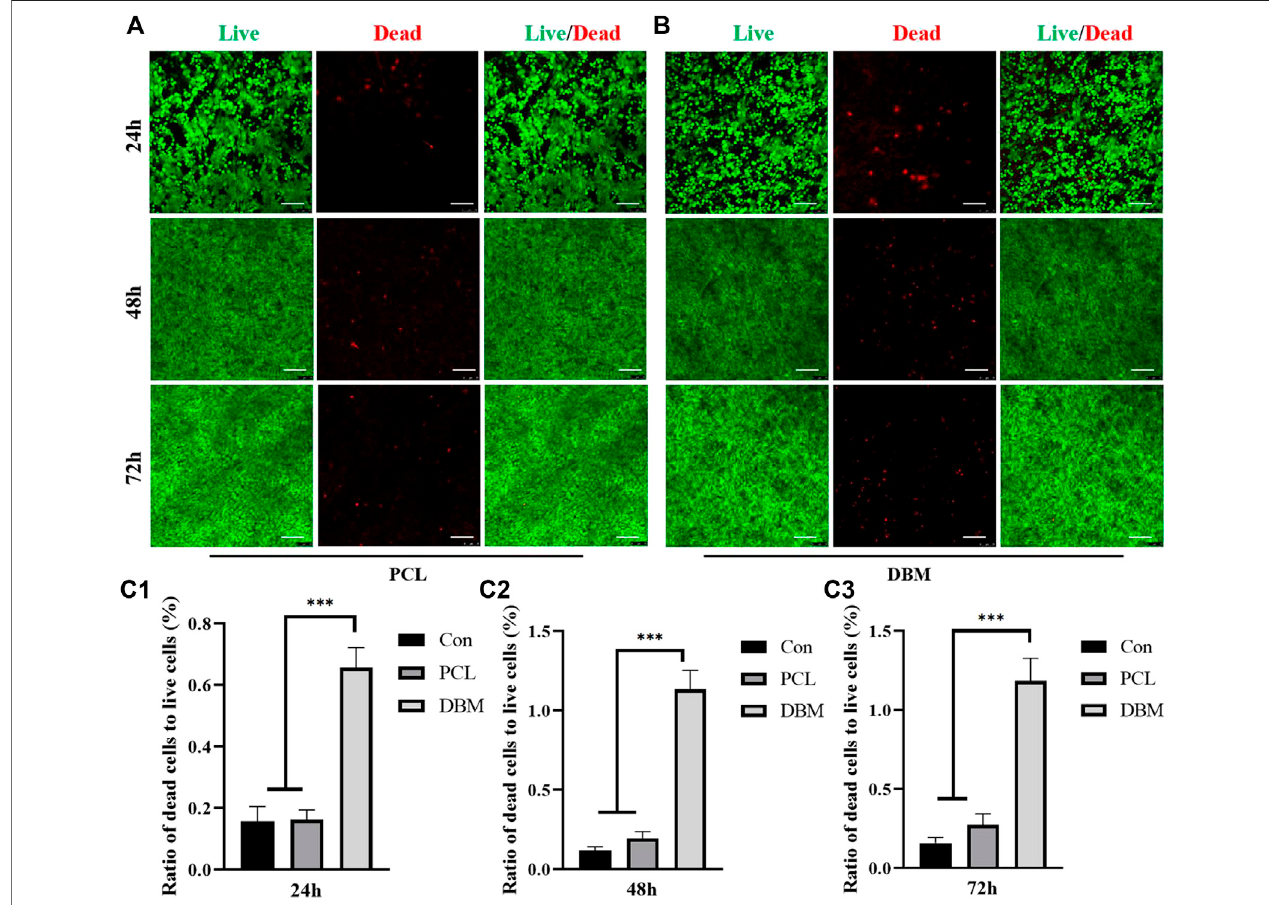
FIGURE 3 | Cytotoxicity evaluation of the frameworks to ECG. (A) Live/dead staining of ECG in PCL leach solution for 24, 48, and 72 h; (B) Live/dead staining of ECG in DBM leach solution for 24, 48, and 72 h; Semi-quantitative analysis for the ratio of dead cells to live cells at 24h (C1) , 48h (C2) , and 72h (C3) . Statistical signi fi cance: ppp p < 0.001. Scale bar: 100 μ